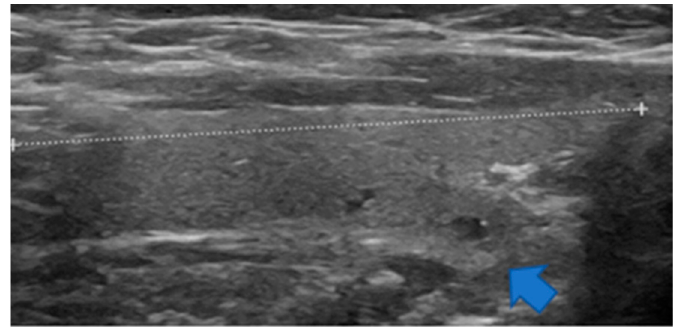
Figure 3. Sagittal view of a non-enlarged thyroid lobe. At the lower portion, there is a downward and backward protrusion named the posteroinferior horn herein (blue arrow).